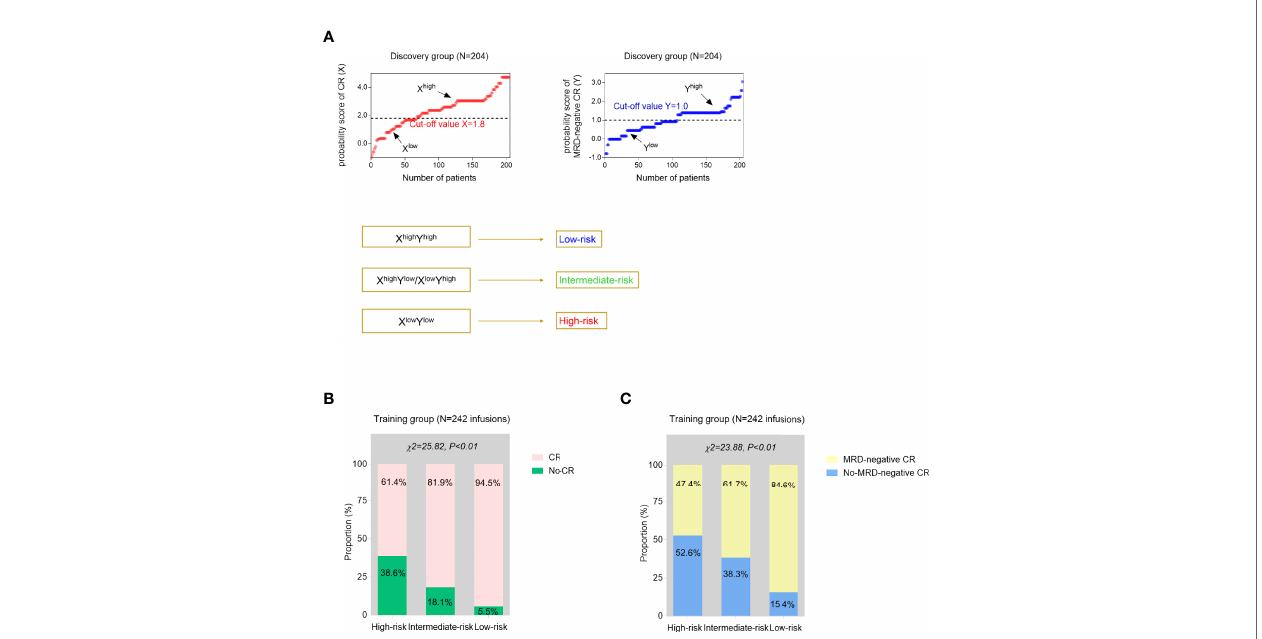
FIGURE 3 | Development and validation analyses of the established models. (A) Using the CR-predicted and MRD-negative CR-predicted models, each time of CAR-T cell infusion could be evaluated as high probability of CR (X high ) or low probability of CR (X low ), high probability of MRD-negative CR (Y high ), or low probability of MRD-negative CR (Y low ) with the cutoff values generated from the discovery cohort. Then, two independent predictive models were further integrated as one risk strati fi cation model based on the simultaneous estimation of the probability of CR and MRD-negative CR. (B, C) The proportions of CR (B) and MRD-negative CR (C) infusions were compared among three risk groups from the training group. p values were calculated via the chi-square ( c 2 )